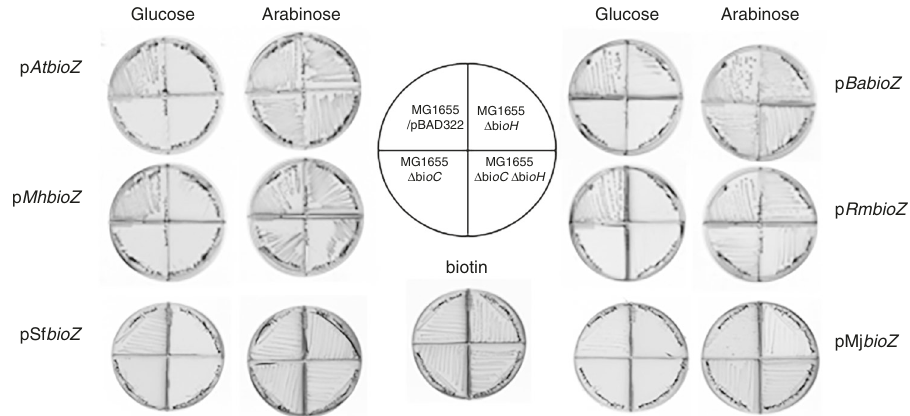
Fig. 3 Diverse BioZ proteins complement E. coli strains having deletion alleles of bioC , bioH, or deletion alleles of both bioC and bioH . The α - proteobacterial bioZ genes were obtained by PCR ampli fi cation from the genomic DNAs and inserted into the arabinose expression vector pBAD322. The resulting plasmids were then transformed into the E. coli biotin auxotrophic strain and single transformant colonies were streaked onto biotin-free medium with either glucose or arabinose as sole carbon source as shown in the left and right columns of petri plates. The plates are divided into quadrants by plastic walls to prevent cross-feeding. Arabinose induces the pBAD promoter that drives BioZ expression, whereas glucose represses promoter activity. The plate below the plate-loading cartoon contained biotin. MG1655/pBAD322 denotes a wild-type strain carrying the empty arabinose vector plasmid. The PCR primers are given in Supplementary Table 1 and the strains are given in the Supplementary Table